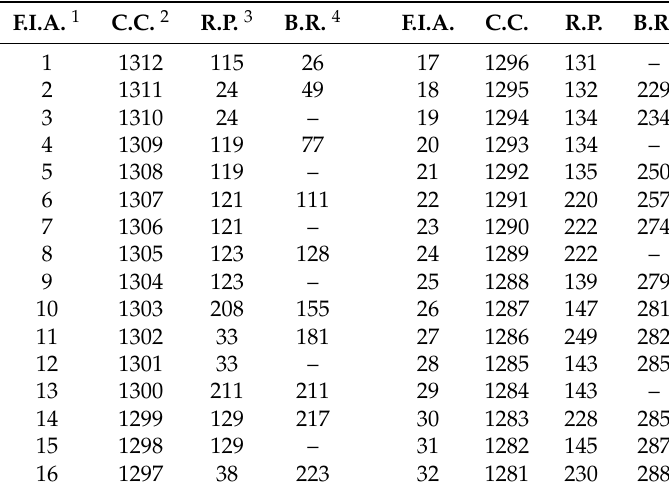
Table 4. Results obtained from the attack on Trivium